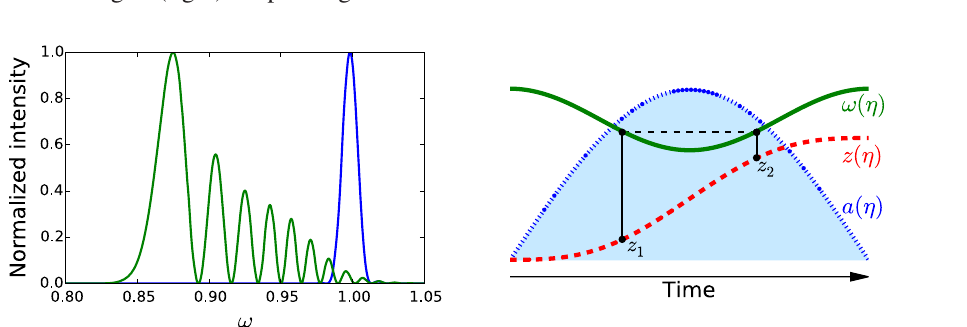
FIG. 1. Left: An example of the normalized on-axis spectra of reflected radiation calculated for low a 0 ¼ 0 . 05 (blue line) and high a 0 ¼ 0 . 4 (red color) scattering lasers, demonstrating the appearance of bandlike structure in the spectrum. Right: Qualitative illustration of the broadening and band formation mechanism in the nonlinear response of an electron to a strong electromagnetic wave. A laser pulse impinges the electron from the left side (from z → −∞ ). As functions of time, the blue line and shaded area represent the laser pulse envelope, the green line shows the frequency of the reflected wave in accordance with Eq. (2), and the red dashed line shows the longitudinal coordinate of the